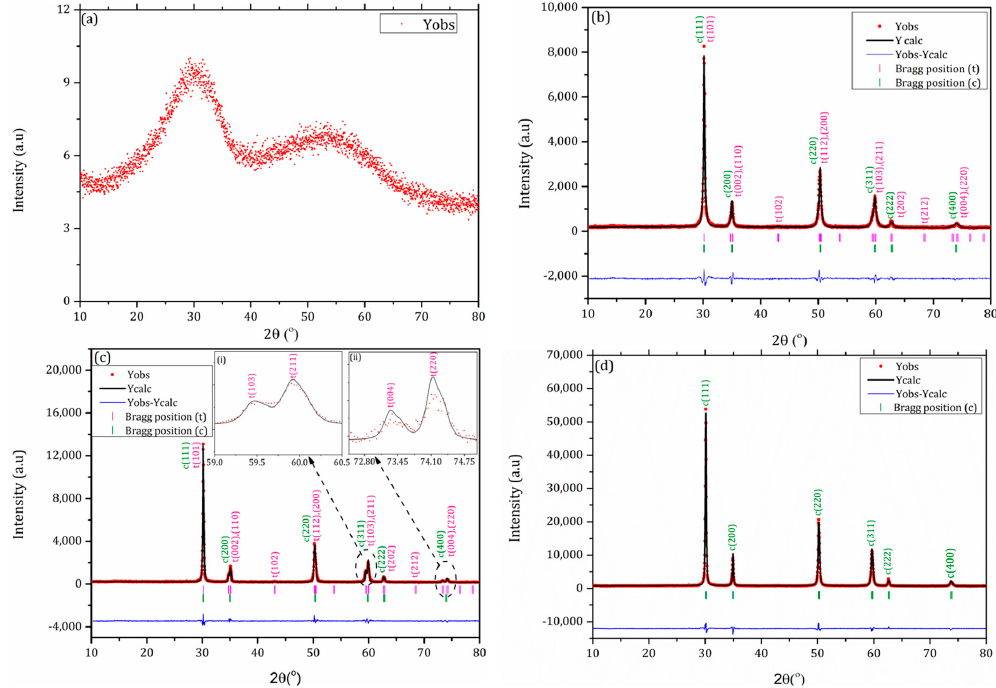
Figure 1. Rietveld refinements of the XRD patterns of 7 YSZ powder calcined for 2 h at: ( a ) 353 K, ( b ) 973 K, ( c ) 1373 K and of 8 YSZ powder calcined at ( d ) 1373 K for 2 h.